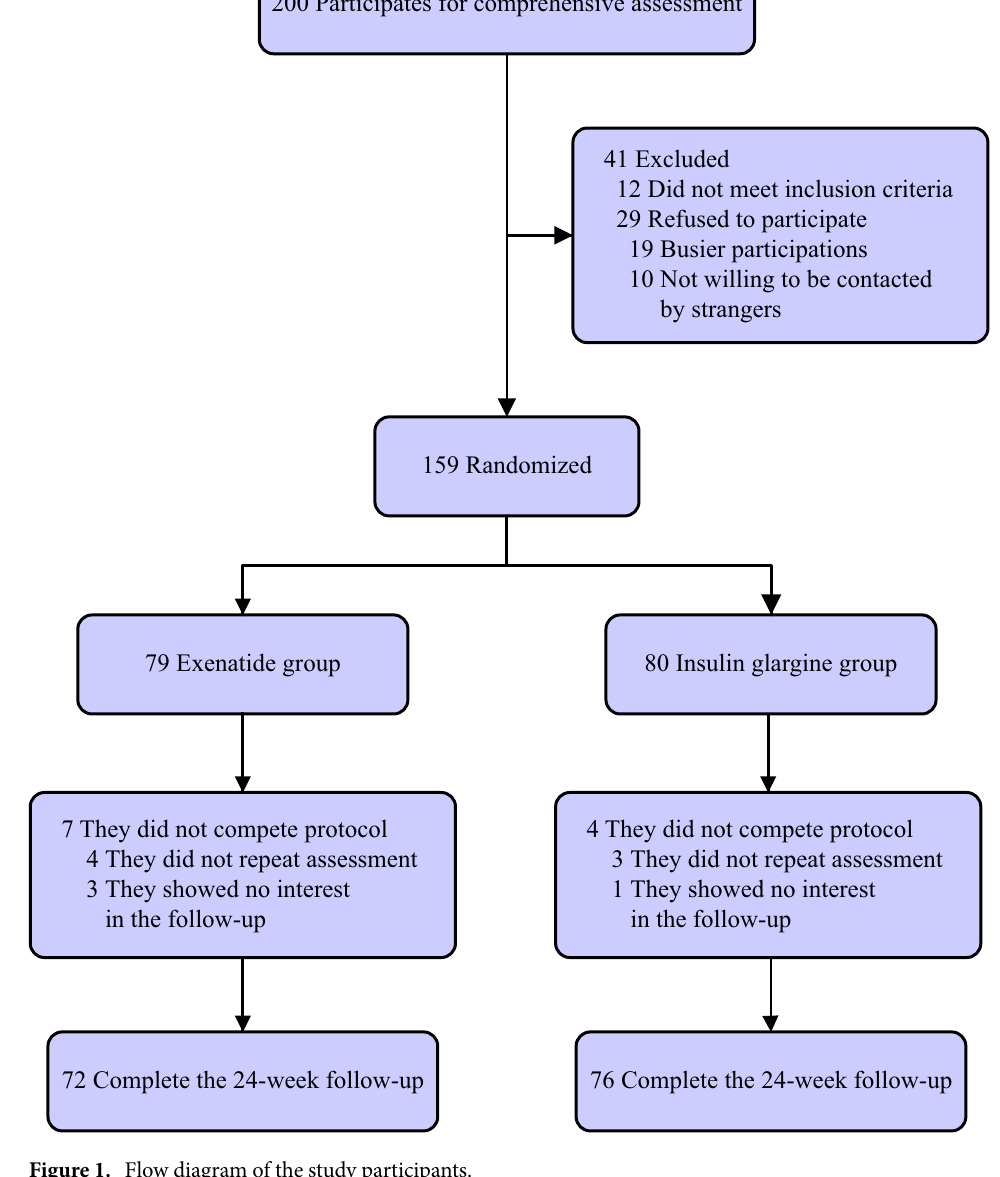
Figure 1. Flow diagram of the study